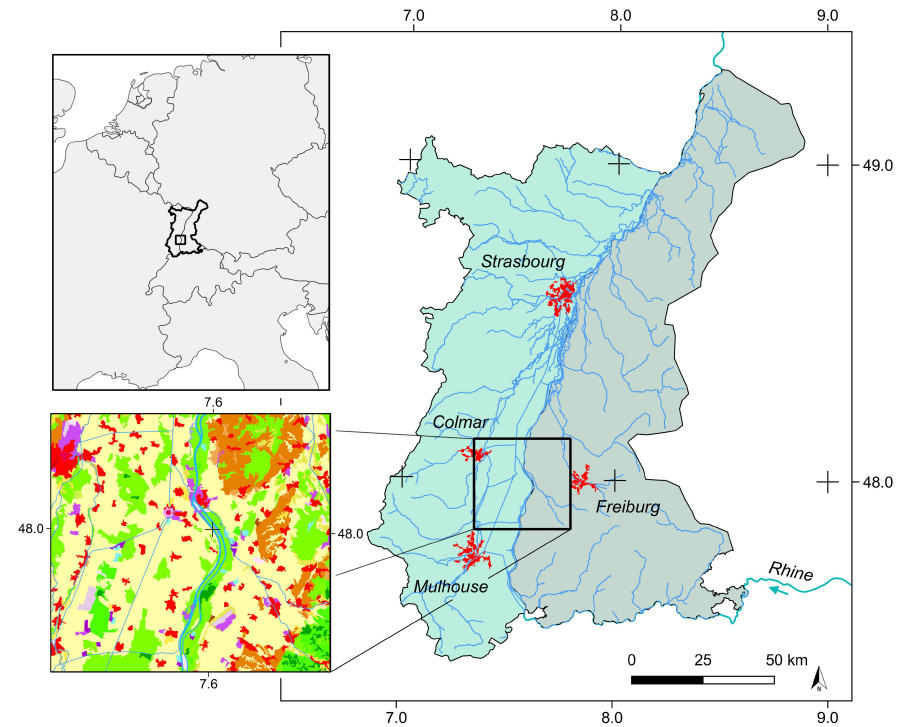
Figure 1. Study area (URG, black polygon) and location of the trans-national case study (black rectangle) with Corine Landcover data (CLC 2018). Red polygons show the larger settlements and urban areas in the Upper Rhine Area (URA). The fluvial system is controlled by the south-north running river Rhine and the tributaries in the French (blue) and German (grey) part of the region.